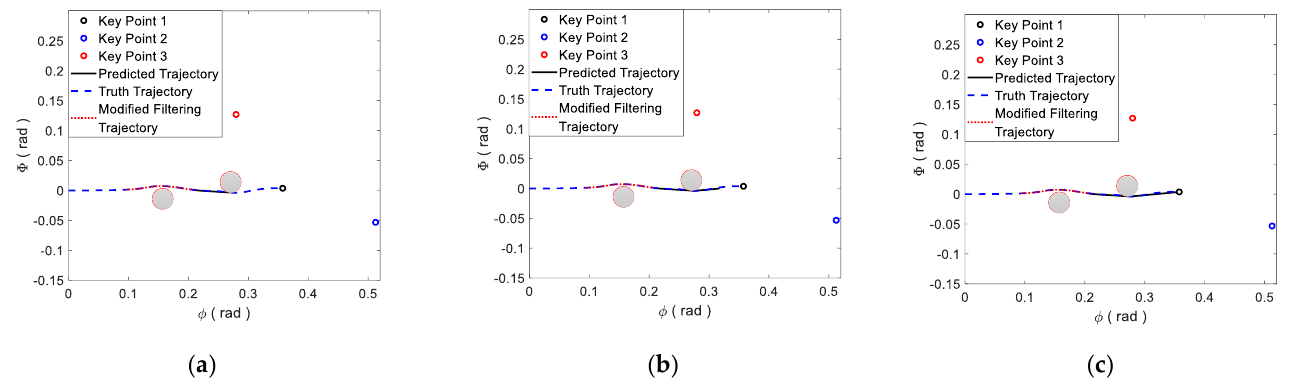
Figure 18. Lateral prediction effect of case 2: (a) is the lateral prediction effect within 100 s; (b) is the lateral prediction effect within 200 s; (c) is the lateral prediction effect within 300 s.